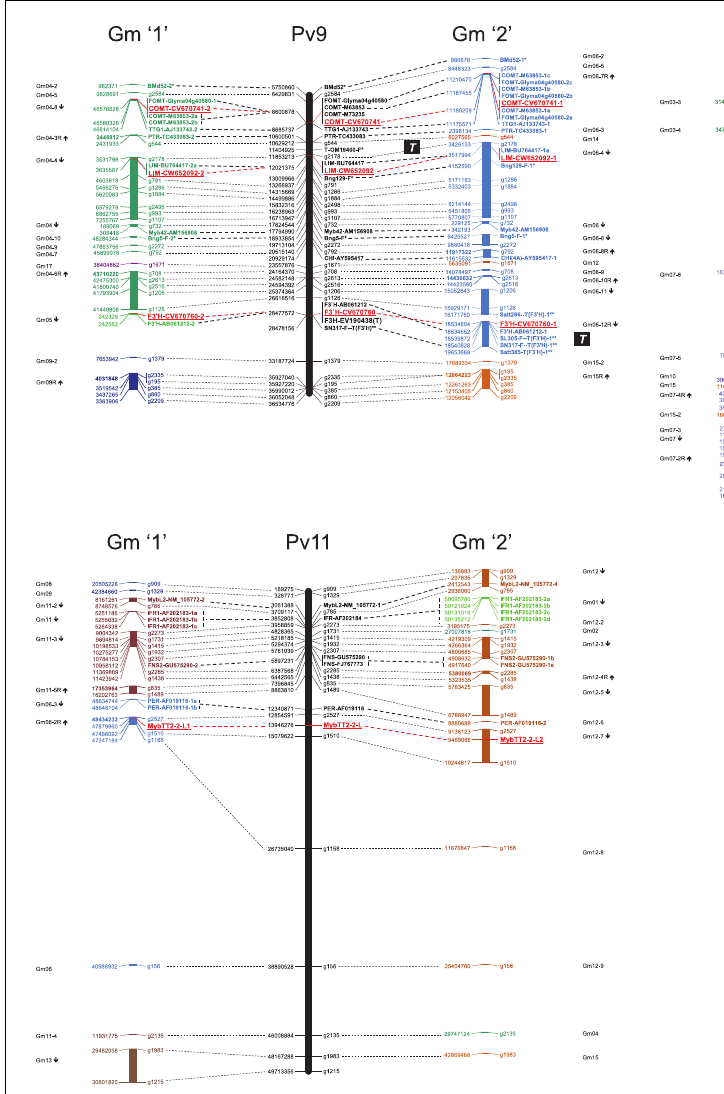
FIGURE 2 | Phenylpropanoid pathway gene sequence-based common bean-soybean comparative map. Marker and phenylpropanoid pathway gene names (abbreviated plus accession number) are shown on right of each chromosome. Feature position [bp, start nt shown (Phytozome)] is indicated on left of each chromosome. Syntenic fragments of soybean chromosomes (each in different color) are shown on left (copy “1”) and right (copy “2”) of common bean chromosome (black). Phenylpropanoid pathway gene fragments cloned in this study are shown in red, bold, and underlined. Tentative positions of seed coat color genes are shown in black blocks. Enzyme abbreviations: PAL, phenylalanine ammonia lyase; C4H,